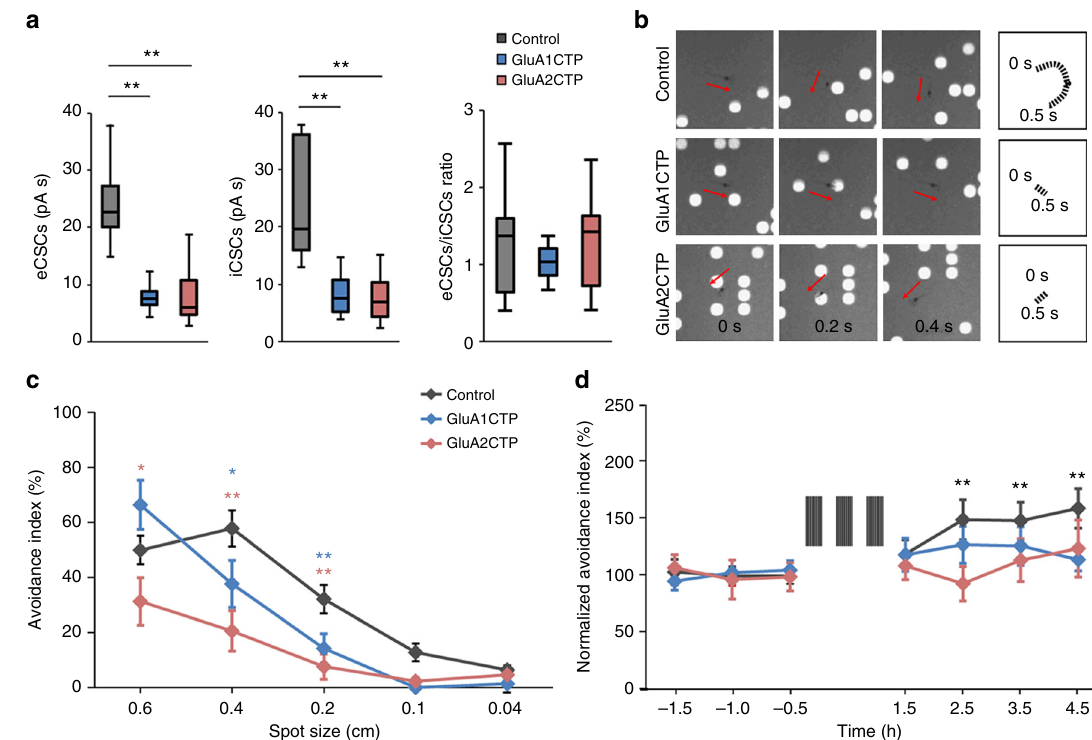
Fig. 8 GluACTP expression impairs visual avoidance behavior and behavioral plasticity. a Expression of GluA1CTP or GluA2CTP with bulk electroporation signi fi cantly decreased visually evoked eCSCs and iCSCs in transfected neurons compared to controls. The ratio of eCSCs to iCSCs in GluA1CTP- and GluA2CTP-expressing neurons remained comparable to control neurons. Control: n = 7; GluA1CTP: n = 8; GluA2CTP: n = 7. b Representative snapshots of tadpole behavior in response to upward moving spot stimuli (diameter 0.4 cm) in animals expressing GFP, GluA1CTP, or GluA2CTP in tectal neurons. Top panel: Control tadpoles turned to avoid an approaching stimulus. The swim trajectory over 500 ms is shown on the right. Tadpoles in which the optic tectum was electroporated with GluA1CTP (middle panel) or GluA2CTP (bottom panel) did not change swim trajectories in response to a moving stimulus. c Summary data: avoidance index in response to stimuli of diameters 0.04 – 0.6 cm for animals expressing GFP (control, n = 15) or GFP with GluA1CTP ( n = 21) or GluA2CTP ( n = 18) in the optic tectum. d GluA1CTP ( n = 20) or GluA2CTP ( n = 16) expression blocked visual experience-induced enhancement of visual avoidance behavior observed control tadpoles ( n = 18). * P < 0.05, ** P < 0.01. ANOVA with Newman – Keuls test. Error bar: mean ±